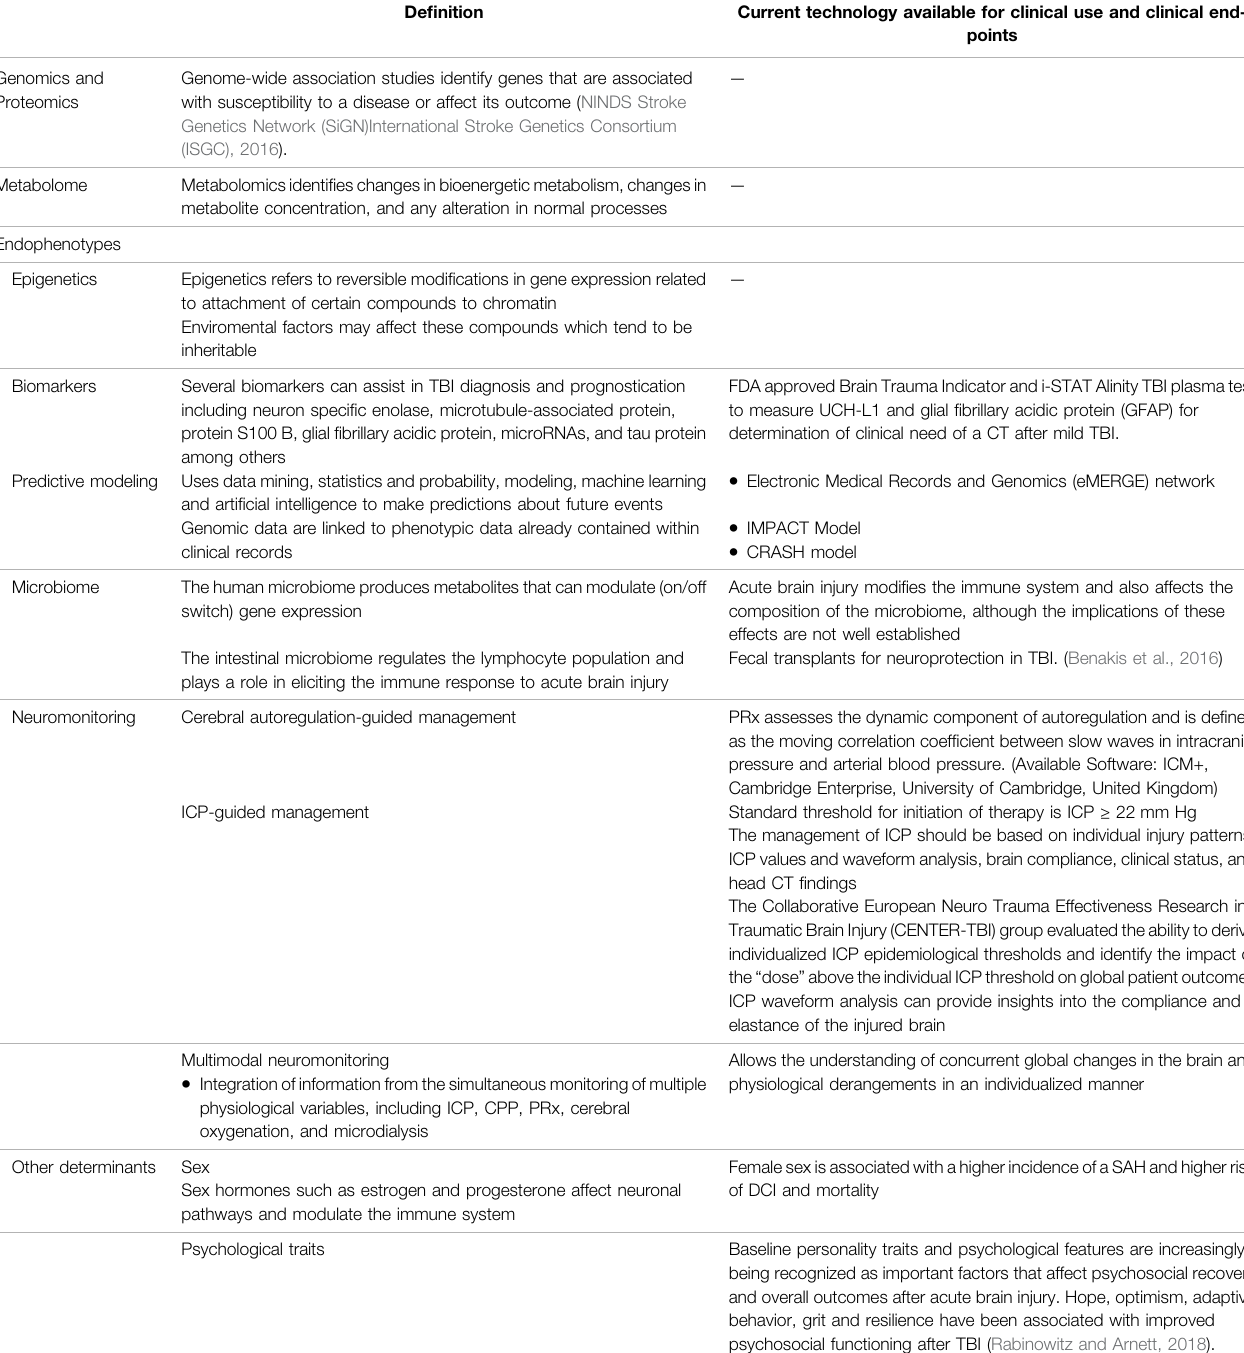
TABLE 1 | Different components of the multimodal approach used in precision medicine.